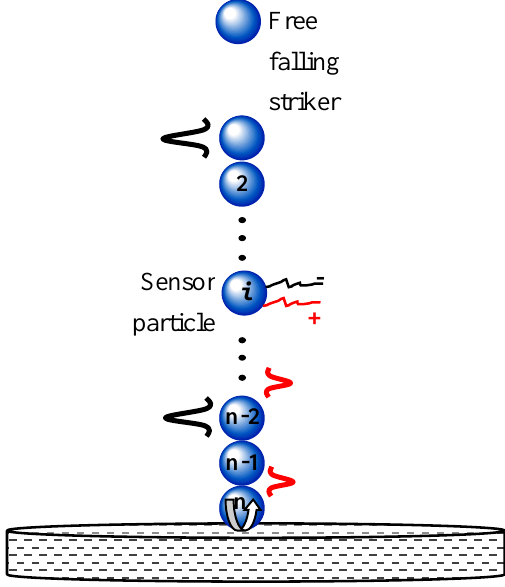
Figure 1. General scheme of nondestructive evaluation / structural health monitoring paradigm using highly nonlinear with different modulus. The advantages and limitations of the proposed wireless platform are given along with some suggestions for future developments.